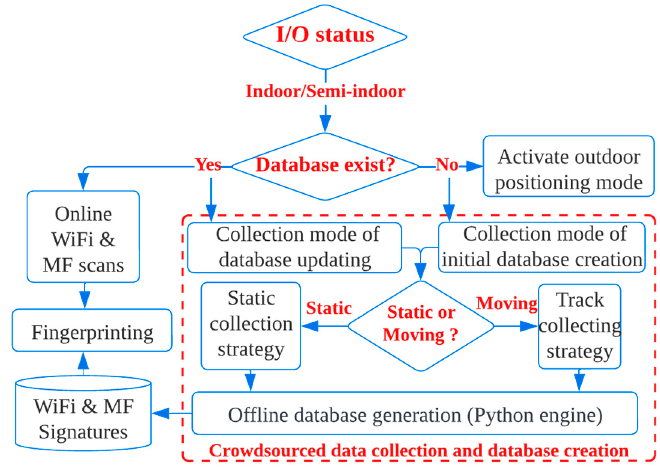
Figure 6. Crowdsourced data collection strategy.